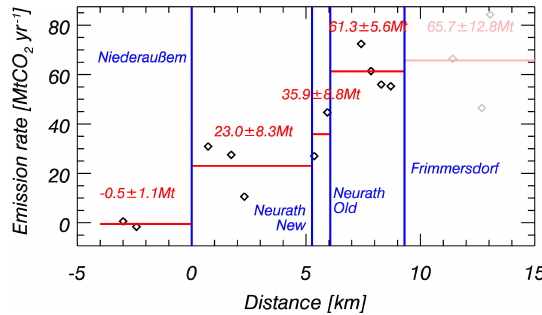
Figure 15. Mass balance results based on MAMAP remote sensing data. Vertical lines denote the location of power plants in a down- wind direction from Niederaußem. Diamonds show emission rates derived from individual aircraft legs, where grey diamonds indicate reduced data quality (see Sect. 3.3.4). Horizontal lines and emission values show average total emissions of the upwind